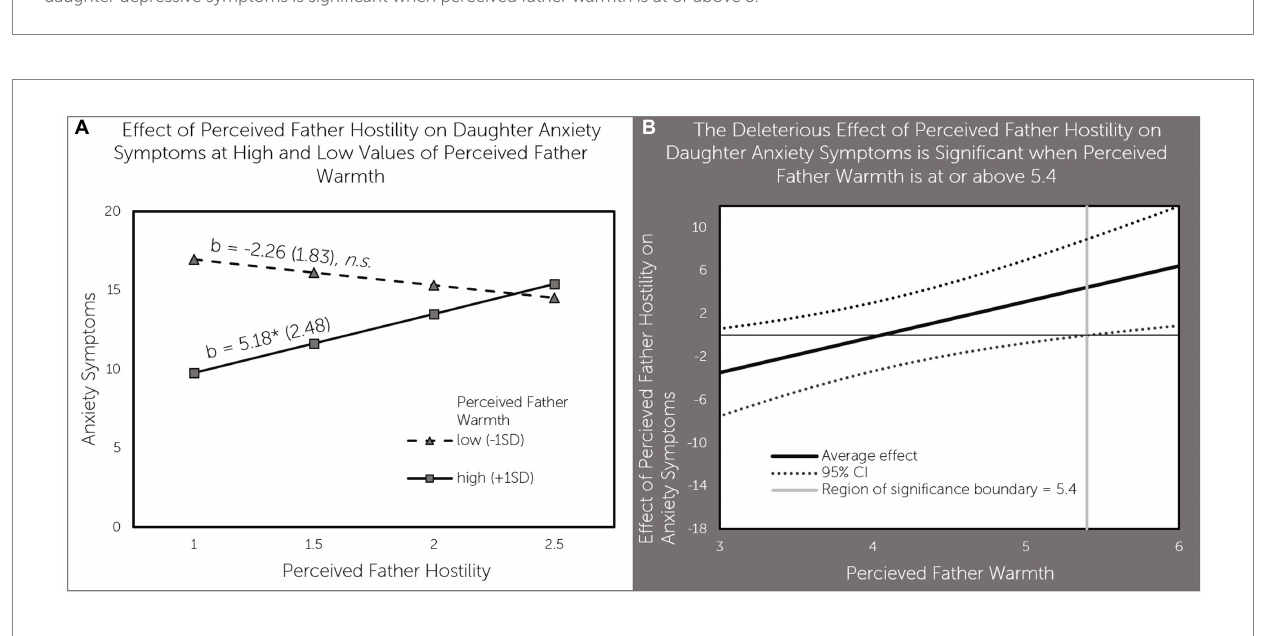
FIGURE 3 Perceived father warmth moderates the effect of perceived father hostility on daughter anxiety symptoms (A) effect of perceived father hostility on daughter anxiety symptoms at high and low values of perceived father warmth; (B) The deleterious effect of perceived father hostility on daughter anxiety symptoms is significant when perceived father warmth is at or above